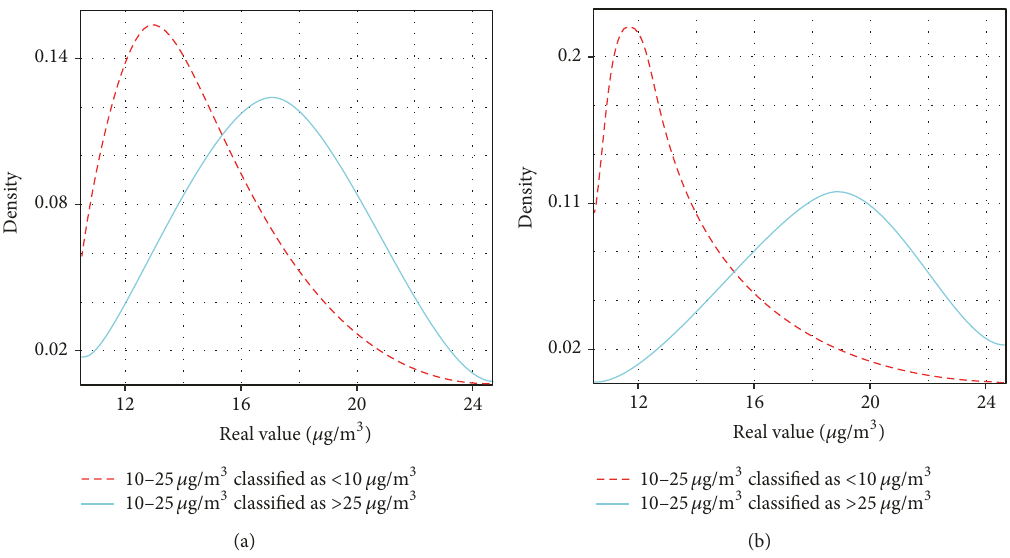
Figure 6: Wrongly classified samples of class 10–25 𝜇 g/m 3 with their real value distributions for Cotocollao (a) and Belisario (b).